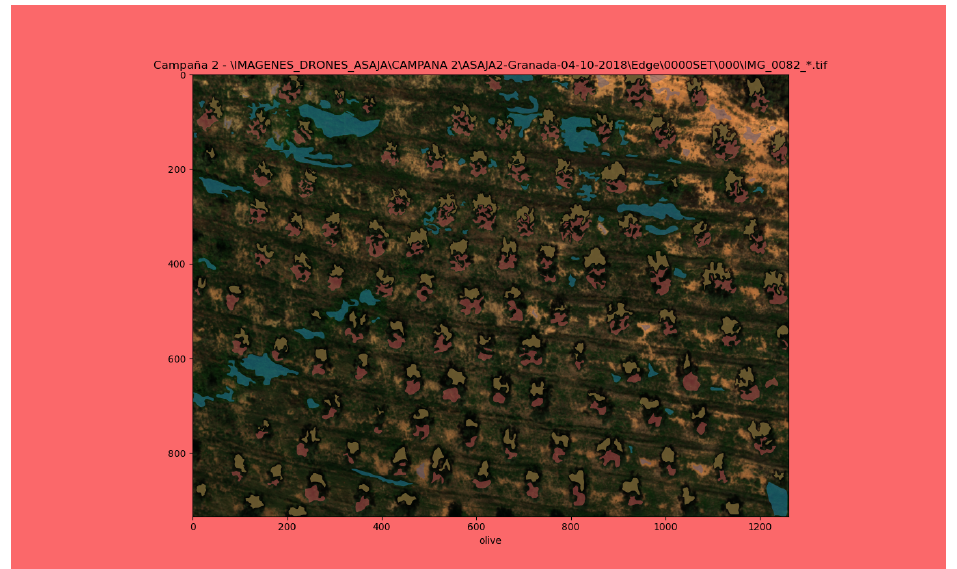
Figure 3. Developed application for the manual labelling of the aerial multispectral images of olive groves. The image shown corresponds to capture 0. The regions are labelled red for the olive tree class, yellow for the shadow class, blue for the weed class and purple for the ground class. The background changes colour to indicate the class selected for